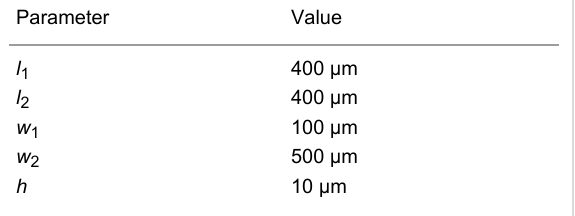
Table 1: Cantilever dimensions shown in Figure